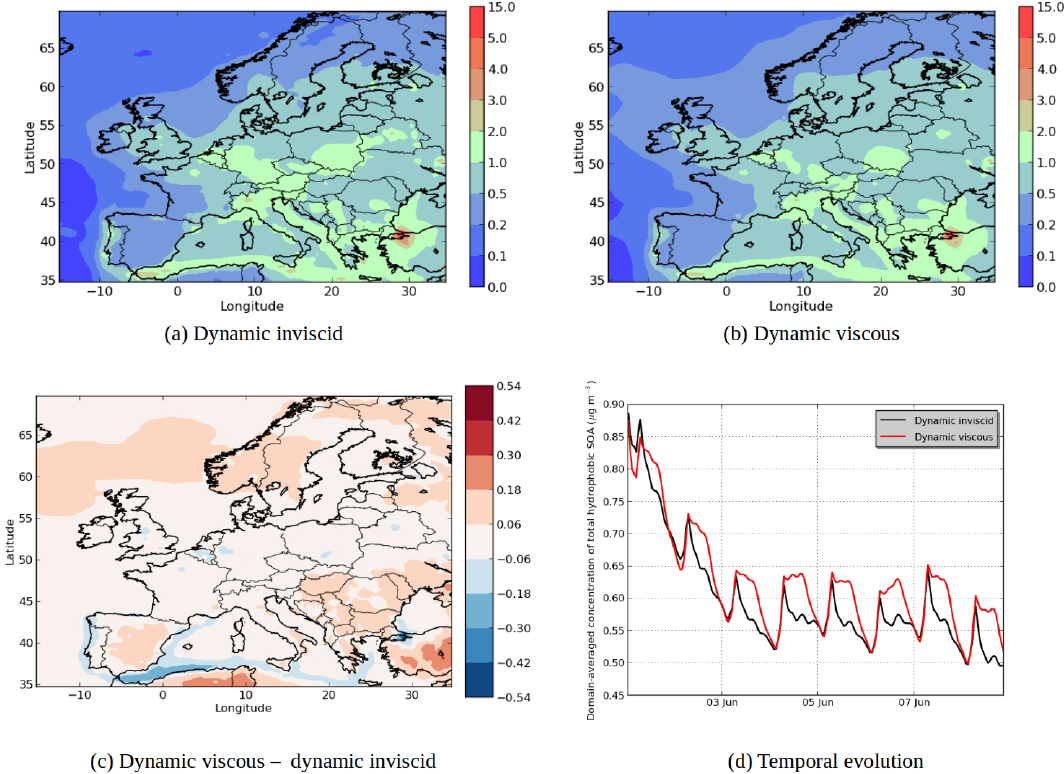
Figure 9. Modeled hydrophobic SOA concentrations in (a) the “Dynamic inviscid” simulation, (b) the “Dynamic viscous” simulation, (c) the differences between the simulations (µgm − 3 ) and (d) the temporal